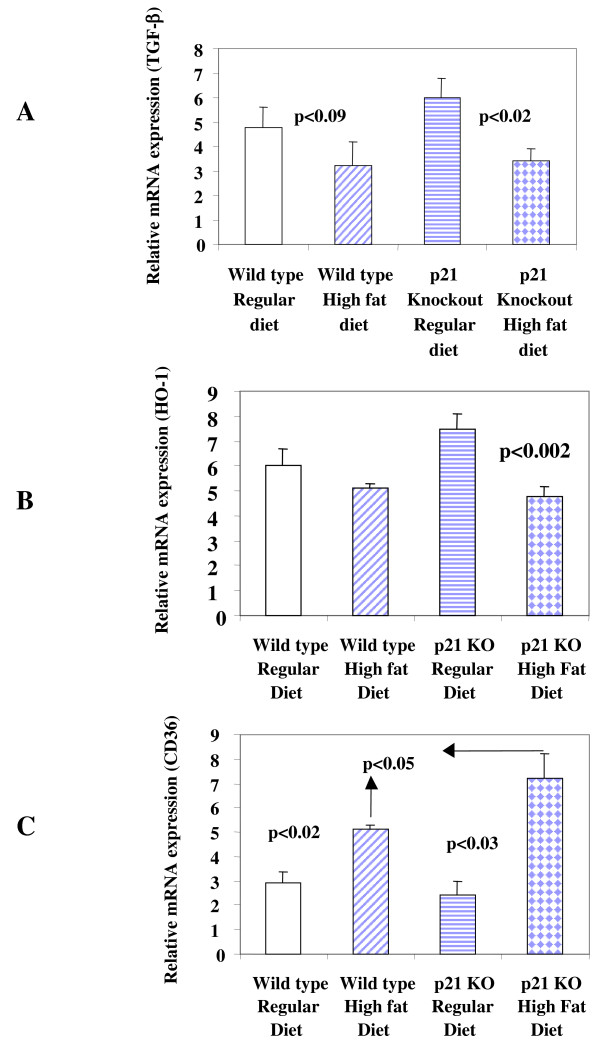
Atherogenesis related gene expression in p21-/- and wild type control mice. Intra-aortic analysis of mRNA expression for anti-atherogenic TGF-β (A), HO-1 (B) and pro-atherogenic gene CD36 (C) is shown. Values presented are means ± SEM in wild type (n = 8) and p21-/- mice (n = 8) fed with regular and high fat diet.